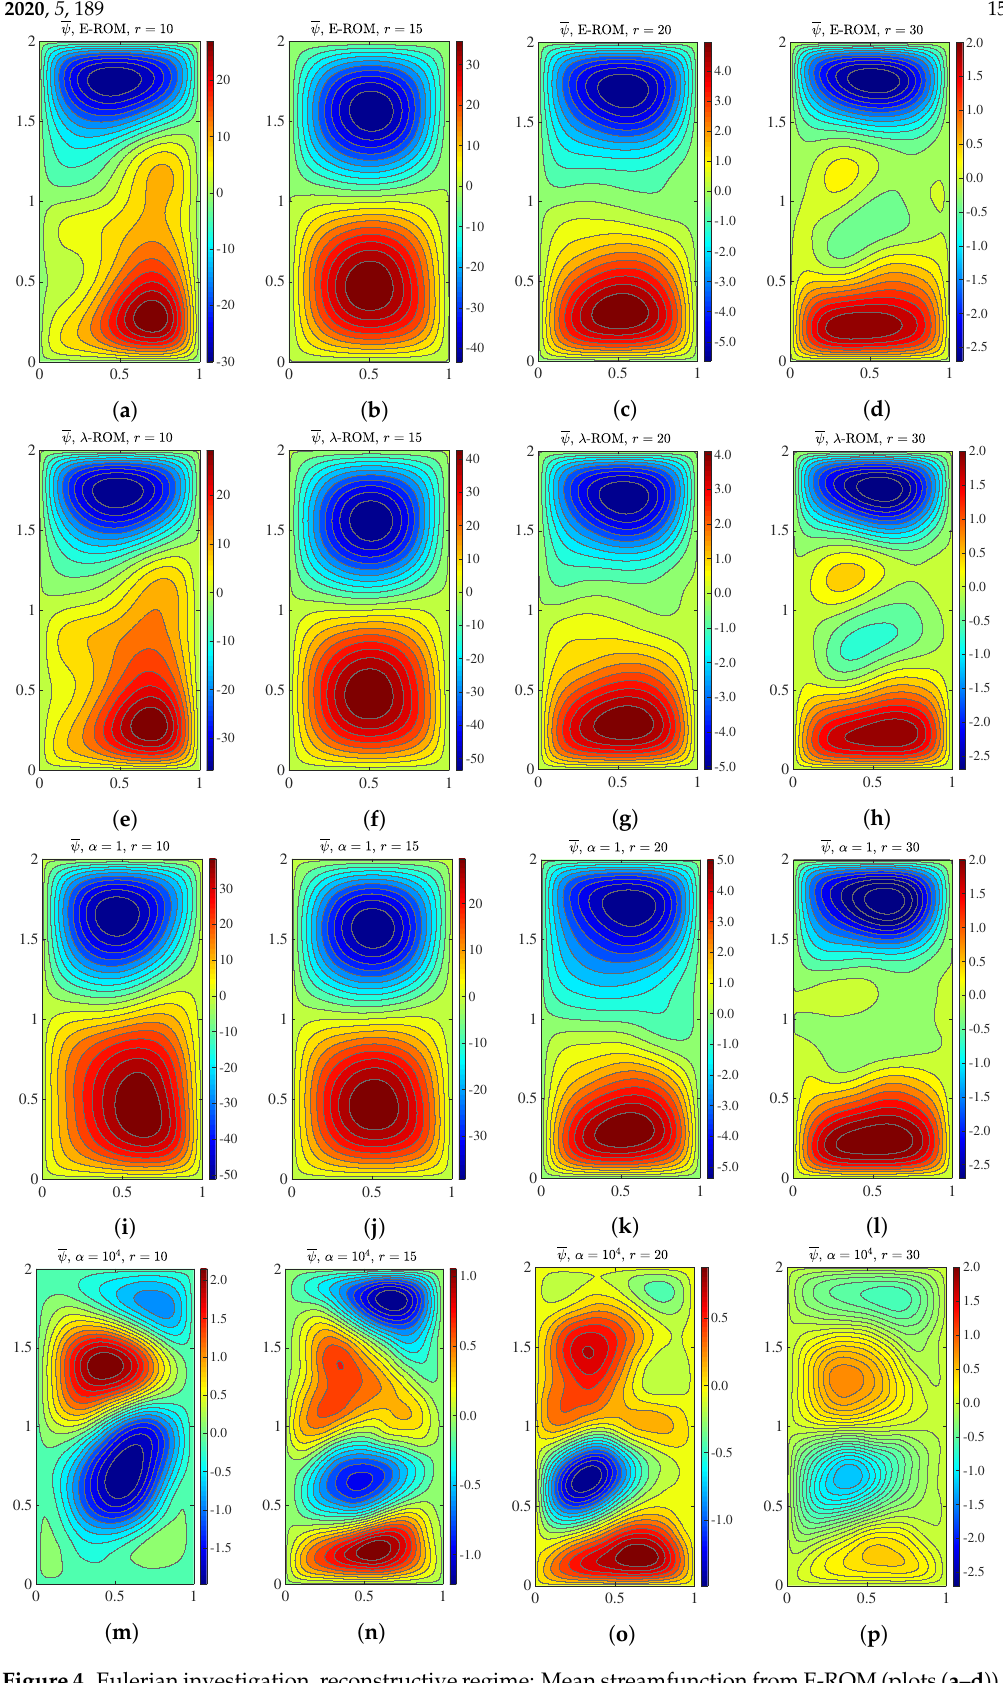
Figure 4. Eulerian investigation, reconstructive regime: Mean streamfunction from E-ROM (plots ( a – d )), λ -ROM (plots ( e – h )) α -ROM with α = 1 (plots ( i – l )), and α = 10 4 (plots ( m – p )), for r = 10 (plots ( a , e , i , m )), r = 15 (plots ( b , f , j , n )), r = 20 (plots ( c , g , k , o )), and r = 30 (plots ( d , h , l , p